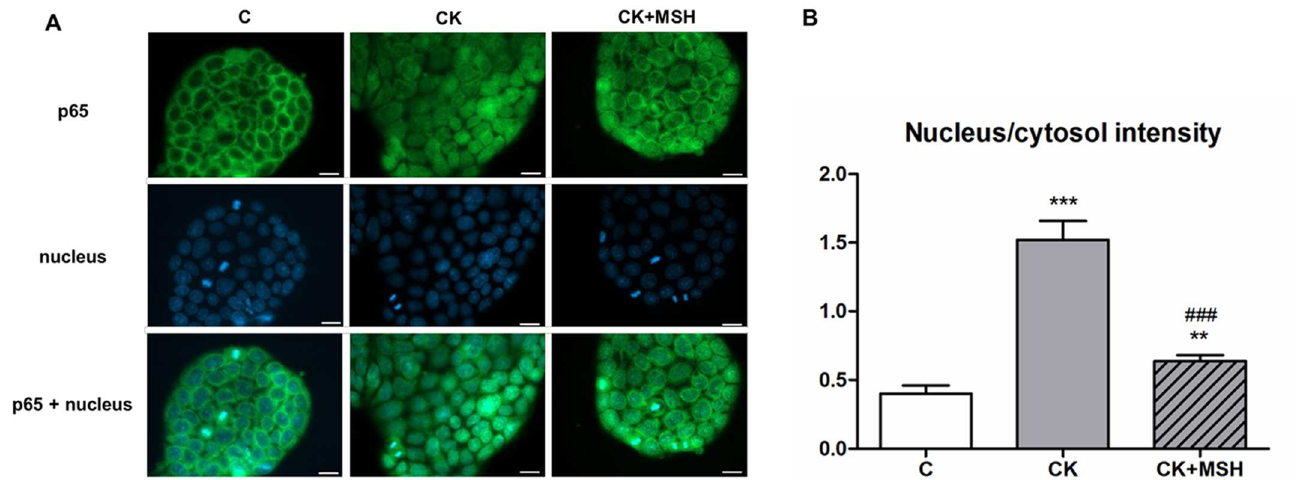
Fig 5. Immunohistochemical staining and analysis of NF- κ Bactivation in cytokine- and α -MSH-treated Caco-2 cells. ( 5A ) Caco-2 cells were treated for 30 minutes with culture medium (C), cytokines (CK; 50 ng/ml TNF- α and 25 ng/ml IL-1 β ), or cytokines and 10 − 8 M α -MSH (CK+MSH). Nuclear localization of the NF- κ B p65 subunit was monitored by immunostaining. Cell nucleiwere labeledwith Hoechst 33342.Green: p65 staining; blue: cell nuclei.Scale bar: 10 μ m. ( 5B ) Ratio of the fluorescence intensity of the NF- κ B immunostaining in cell nucleiand cytoplasm. Means ± S.D., n = 8–10, *** P < 0.001, ** P < 0.01,### P < 0.001. * : CK, CK+MSH comparedto C; #: CK+MSH comparedto